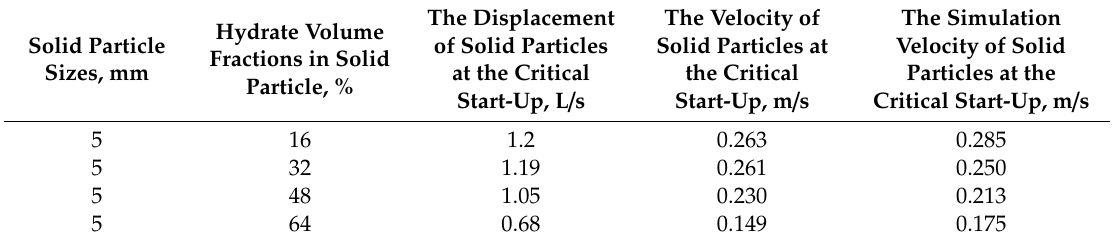
Table 4. The experimental data under di ff erent hydrate volume